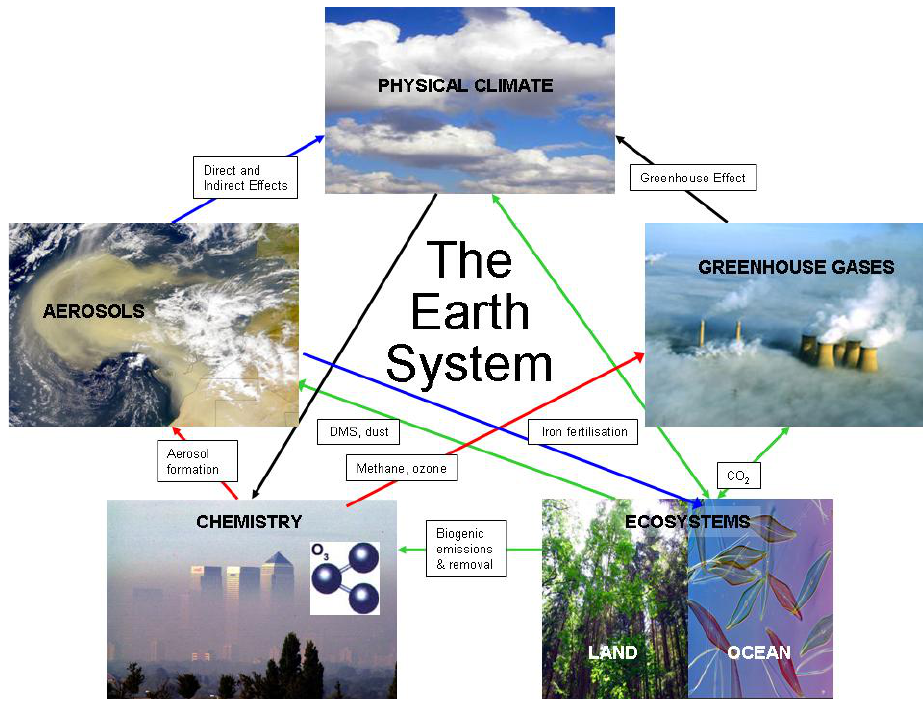
Fig. 3. Earth system couplings